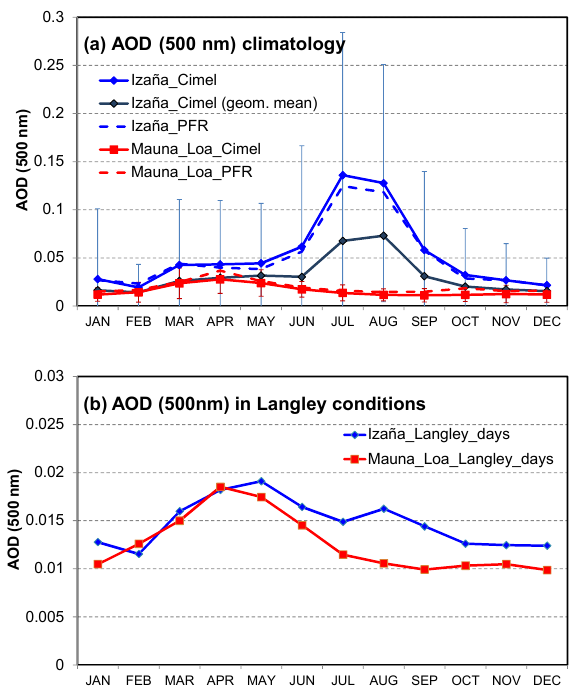
Figure 1. (a) Monthly mean aerosol optical depth (500nm) at Mauna Loa (1994–2016) and Izaña (2004–2016) for AERONET and GAW-PFR. Bars indicate ± 1 monthly standard deviation. The black line indicates geometric mean values for AOD at Izaña (in contrast to the arithmetic mean for the other variables). (b) Monthly mean aerosol optical depth (500nm) for the days fulfilling the cri- teria for Langley calibration as given in Sect.